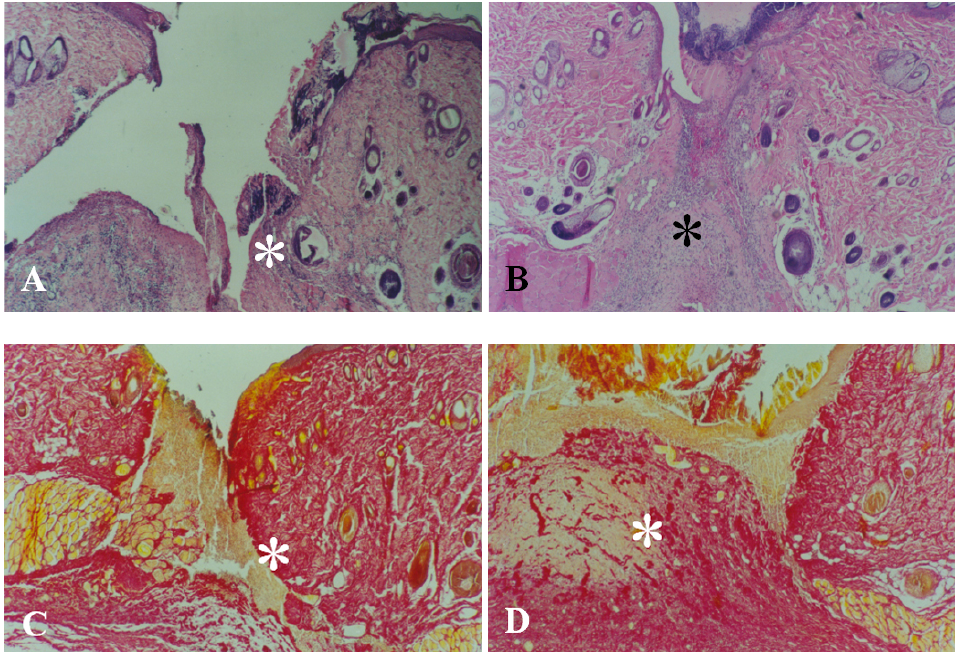
FIGURE 2 - Longitudinal sections of a surgical wound obtained from animals treated with Aloe vera at 2 ( A ) and 10 days ( B ) after the surgical procedure and from animals treated with Aloe vera and microcurrent at 2 ( C ) and 10 days ( D ). The sections were stained with hematoxylin/eosin ( A and B ) and picrosirius ( C and D ). (*)Àrea of tissue healing. Final magnification: